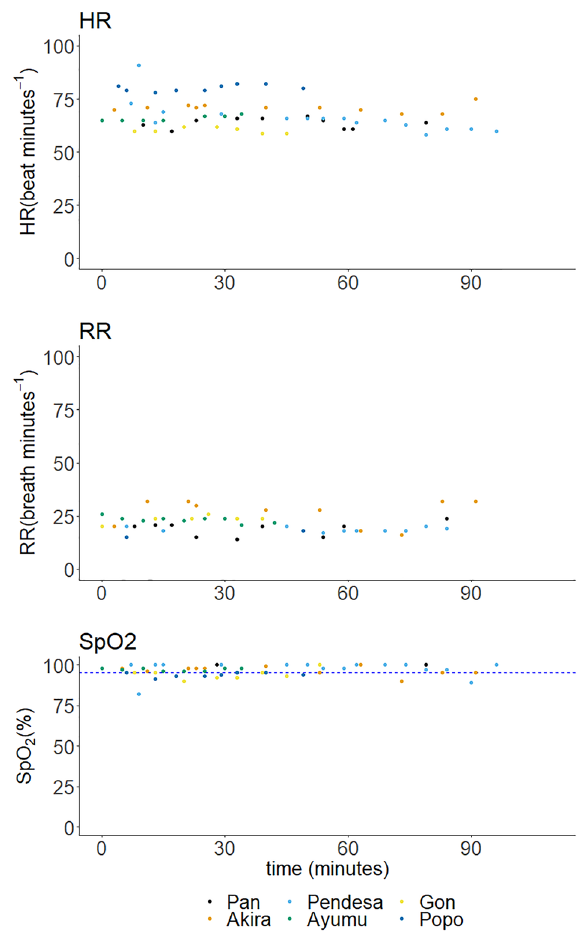
Figure 3. Time course of heart rate (HR), respiratory rate (RR) and percutaneous arterial blood oxygen saturation (SpO 2 ) following propofol TCI in six chimpanzees. Each colored dots indicate values in each